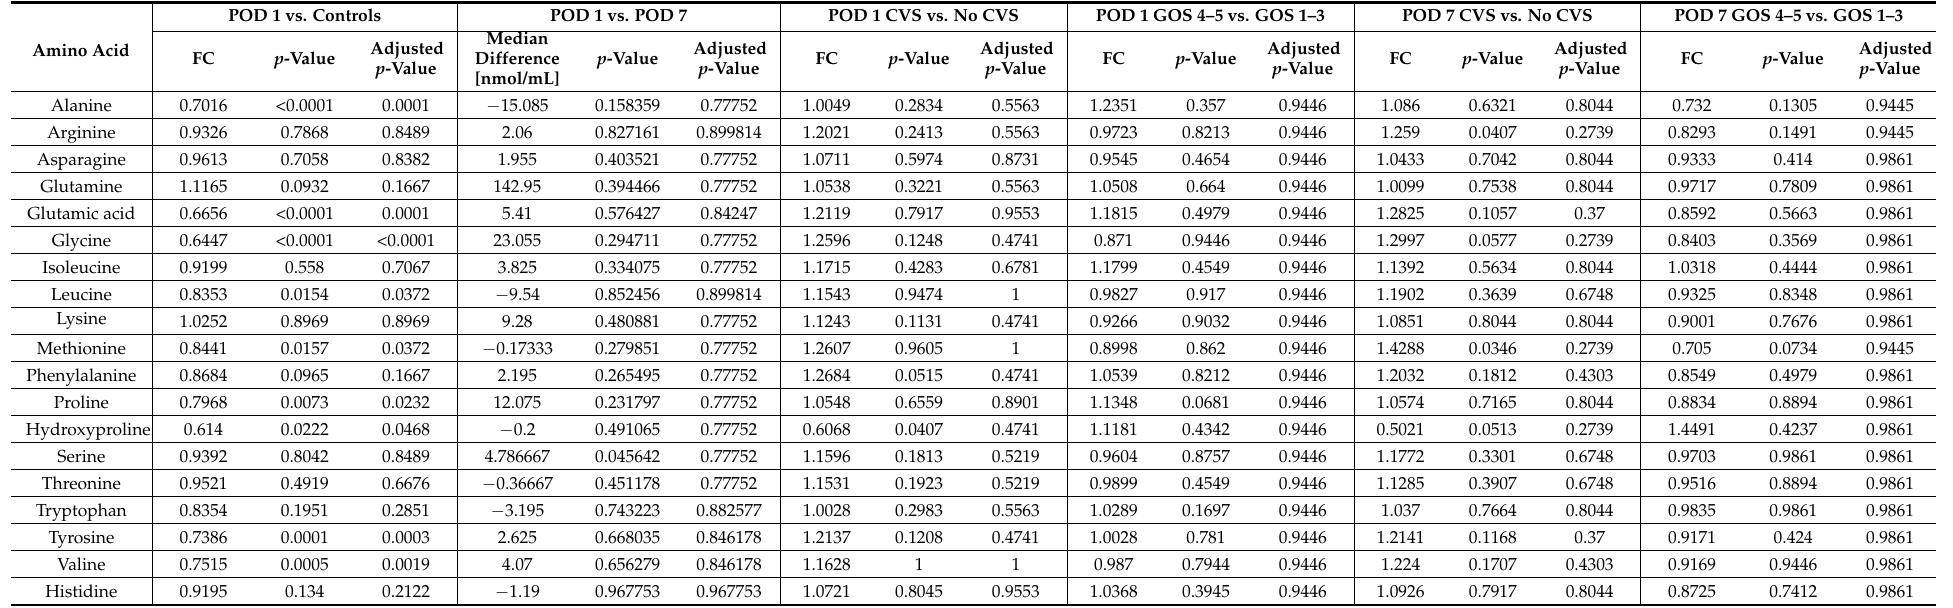
Table 4. Differential concentration of amino acids in comparison without and with Benjamini-Hochberg correction of p -values. Concentrations were compared using U Mann-Whitney